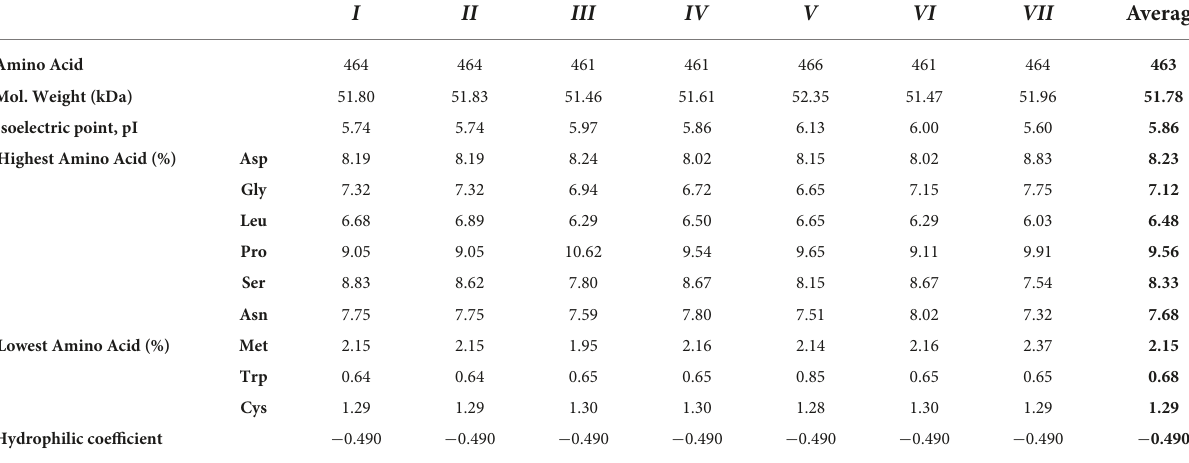
TABLE 2 Table depicting the assessment of amino acids of NAC25 gene isolated from Coffea